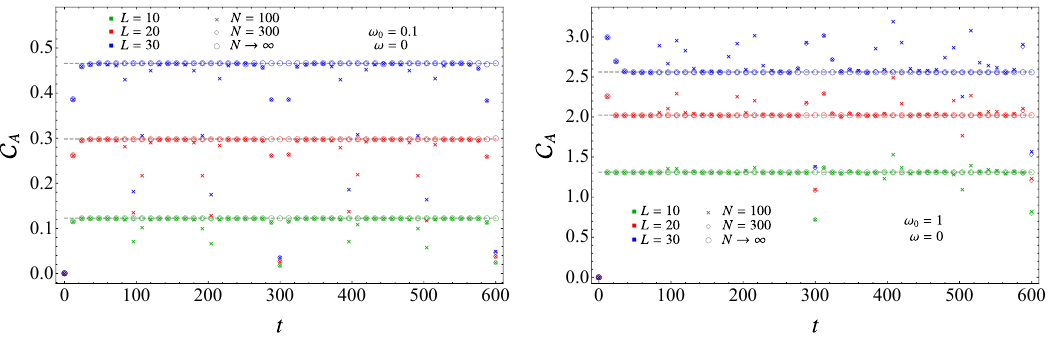
Figure 19 . Temporal evolution of C A after a global quantum quench with a gapless evolution Hamiltonian for a block A made by L consecutive sites adjacent to a boundary of harmonic chains with DBC made by N sites. The data corresponding to N → ∞ are obtained through a chain on the semi-infinite line. The horizontal dashed grey lines correspond to (5.26).